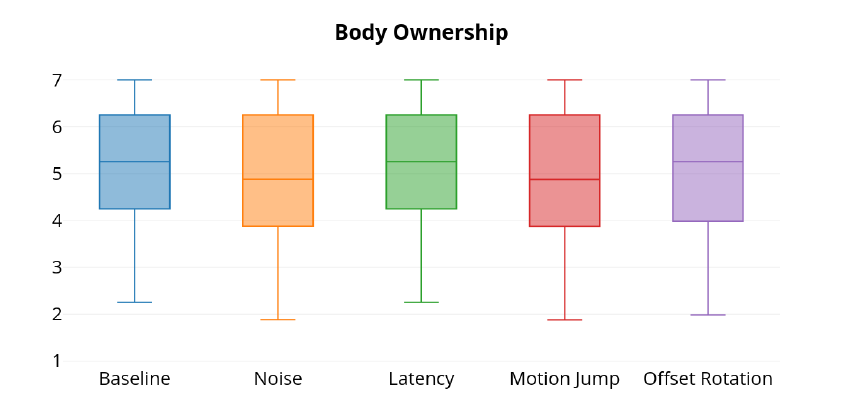
Figure 4. Participants’ responses to questions on body ownership for each of the five conditions of the